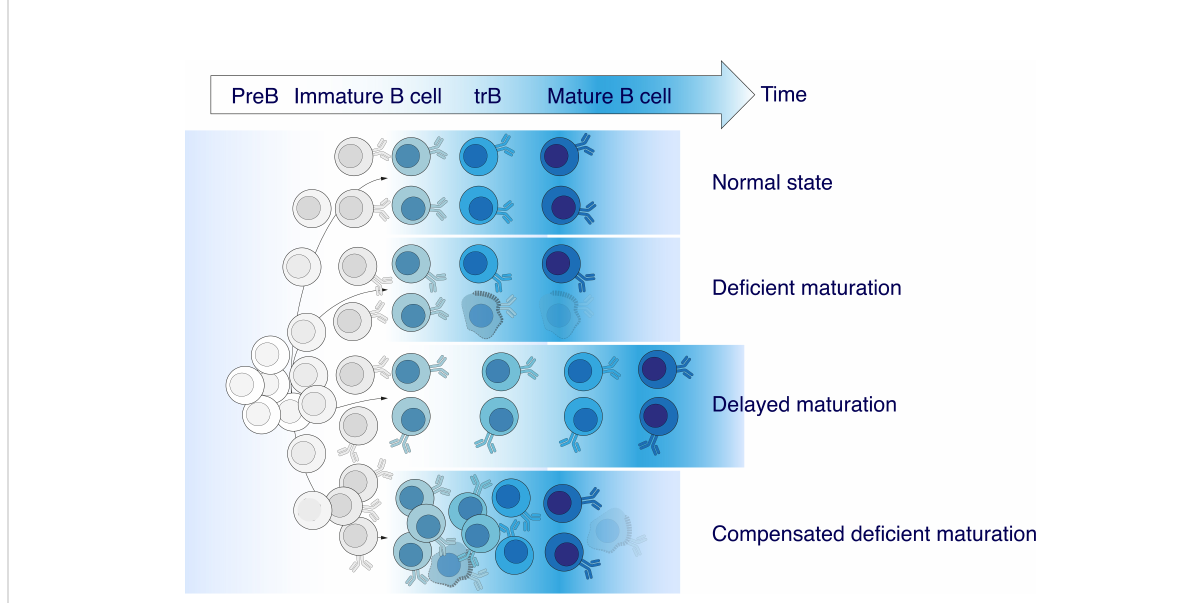
FIGURE 6 Abnormalities in transitional B cell maturation in MS. An elevated frequency of CD19 + CD24 high CD38 high transitional B cells (TrB) observed in MS patients is characterized by greater germline identity compared with healthy donors. There are least three possible coexisting or independent scenarios explaining these fi ndings: ( i ) de fi cient maturation of TrB, ( ii ) delayed TrB maturation, and ( iii ) an increased number of TrB compensating de fi cient